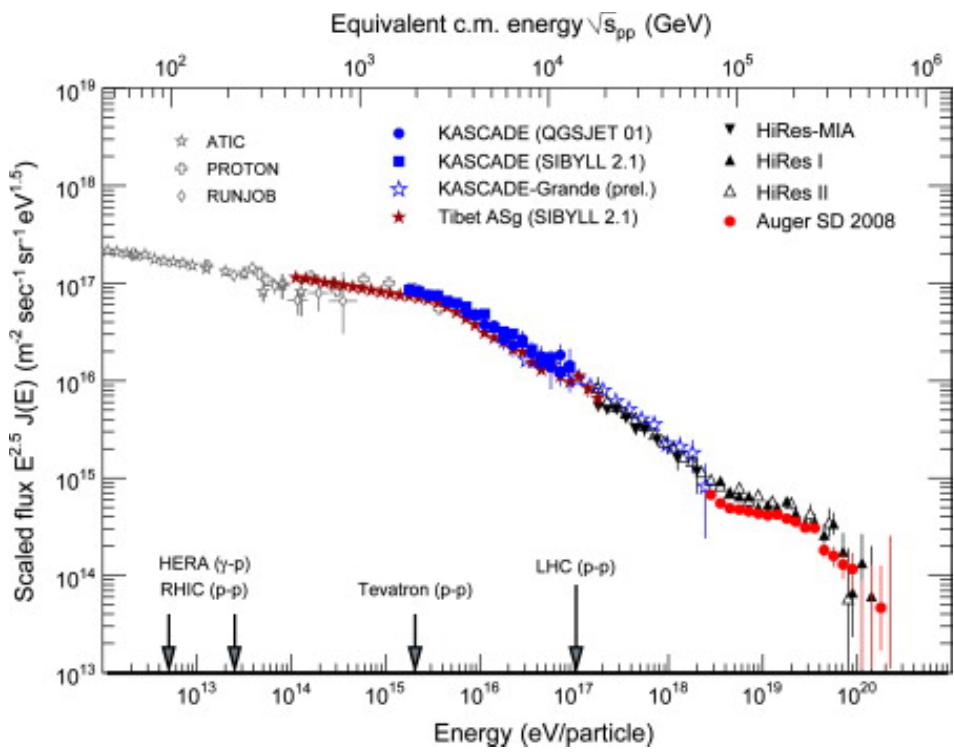
Figure 1. All-particle cosmic-ray energy spectrum as obtained by direct measurements above the atmosphere by the ATIC, PROTON, and RUNJOB, as well as results from air shower experiments, showing Tibet results obtained with SIBYLL 2.1, KASCADE data (interpreted with two hadronic interaction models), preliminary KASCADE-Grande results, and Akeno data. The measurements at high energy are represented by HiRes-MIA, HiRes I and II, and Auger. Reprinted from [9], with permission from Elsevier.